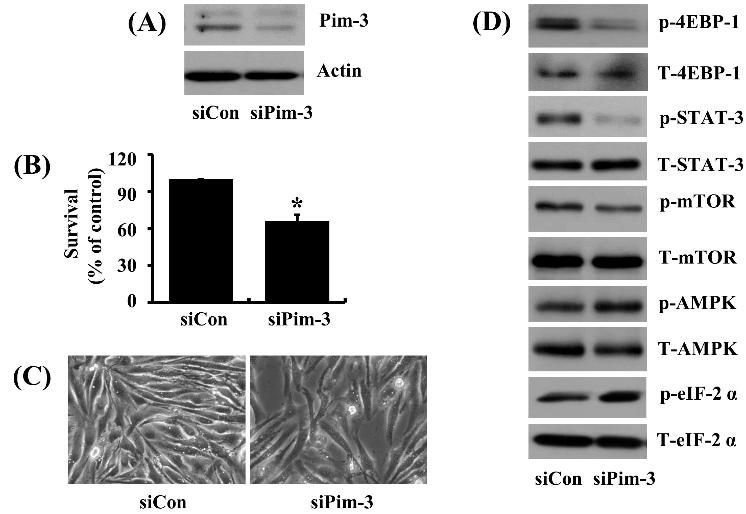
Figure 8. Effect of Pim-3 knock-down on survival of 93T449 cells and cellular expression and/or phosphorylation of 4EBP-1, STAT-3, AMPK, mTOR and eIF-2 α . ( A ) 93T449 cells were transfected with 100 pM of control siRNA (siCon) or Pim-3 siRNA (siPim-3) for 24 h. Whole cell lysates were prepared and analyzed for Pim-3 and β -actin by Western blotting. ( B ) 93T449 cells were transfected with 100 pM of control siRNA (siCon) or Pim-3 siRNA (siPim-3) for 24 h, followed measurement of the number of surviving cells by cell count assay. The cell count assay was performed in triplicate. Data are means ± SE of three independent experiments. * p < 0.05 compared to the siConc at the indicated time. ( C ) Images of the siCon- or siPim-3-transfected cells were obtained by phase contrast microscopy, 400 × . ( D ) 93T449 cells were transfected with 100 pM of control siRNA (siCon) or Pim-3 siRNA (siPim-3) for 24 h. Whole cell lysates were prepared and analyzed for p-4EBP-1, T-4EBP-1, p-STAT-3, T-STAT-3, p-AMPK, T-AMPK, p-mTOR, T-mTOR, p-eIF-2 α and T-eIF-2 α by Western blotting.